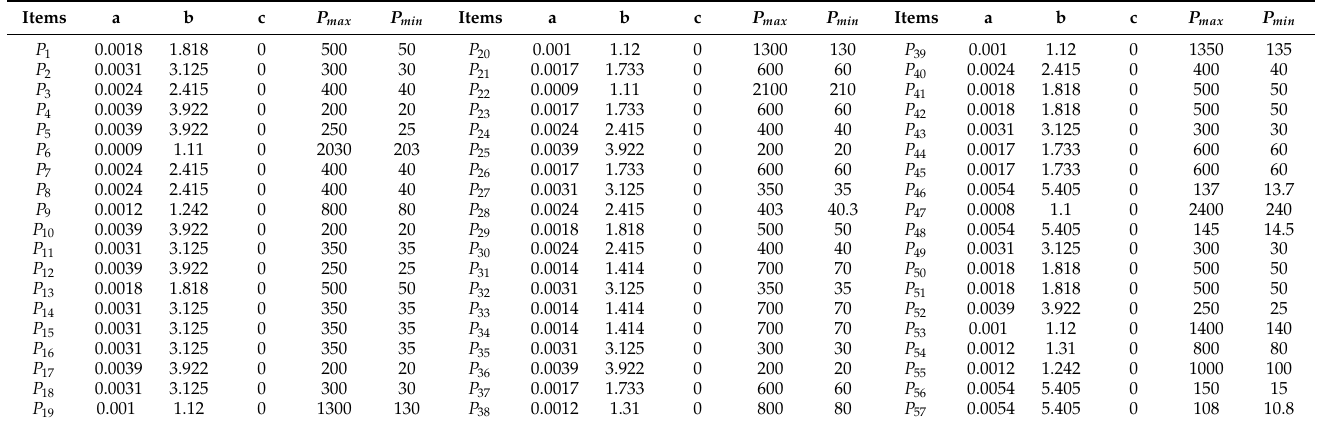
Table A2. Cost coefficients and unit characteristics of Case 2.